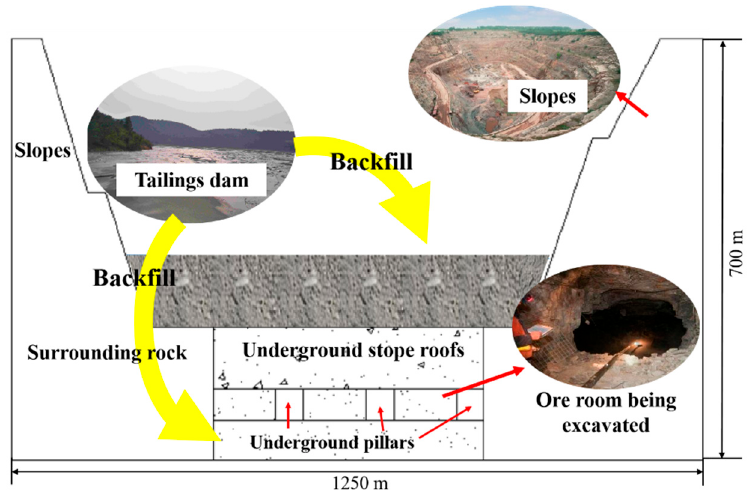
Figure 2. Open pit and underground stopes.